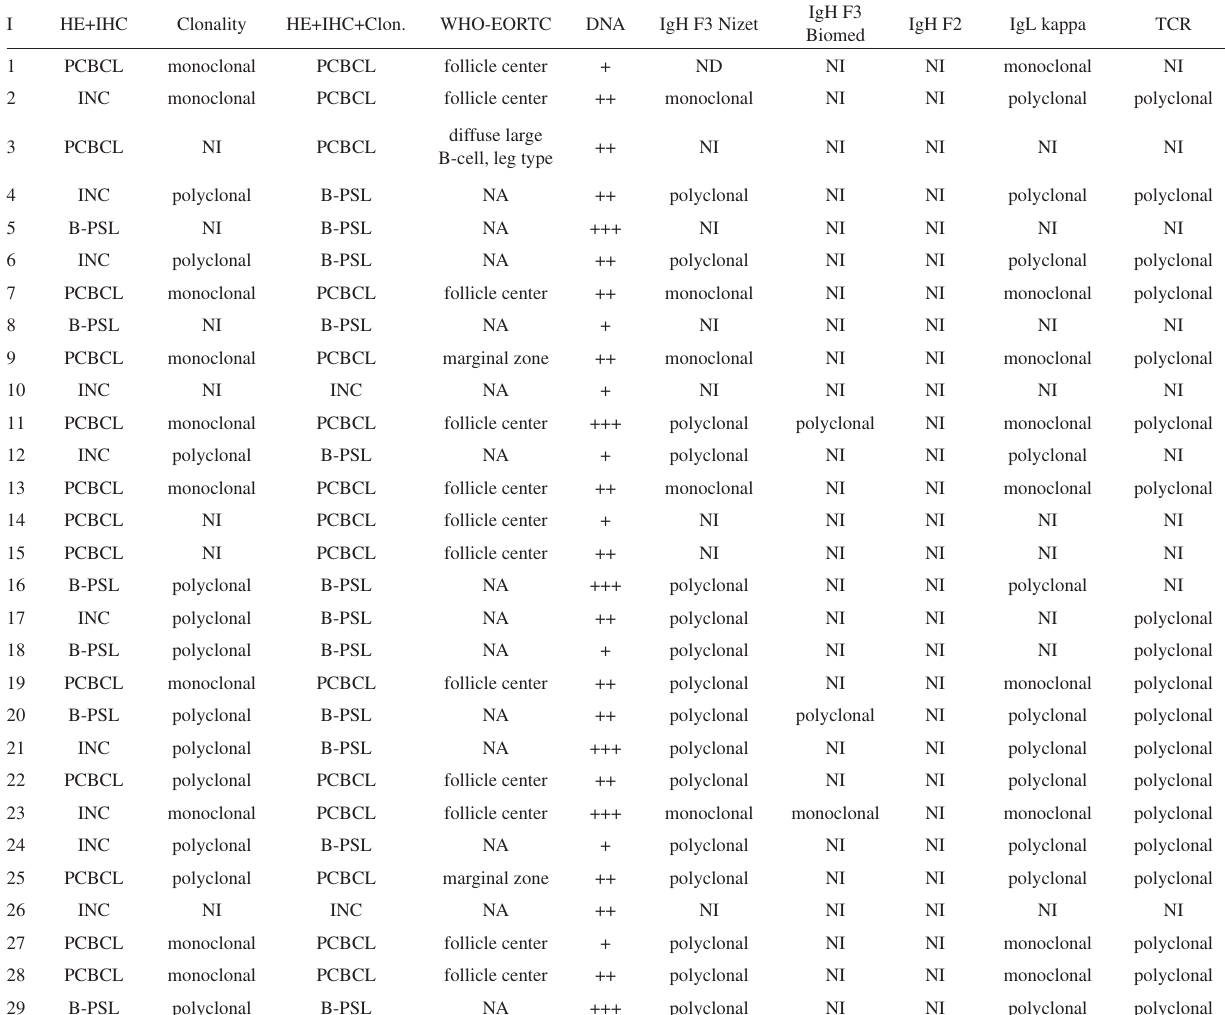
Table 3 - Clonality analysis of the 29 cases with B-cell lymphoproliferative processes